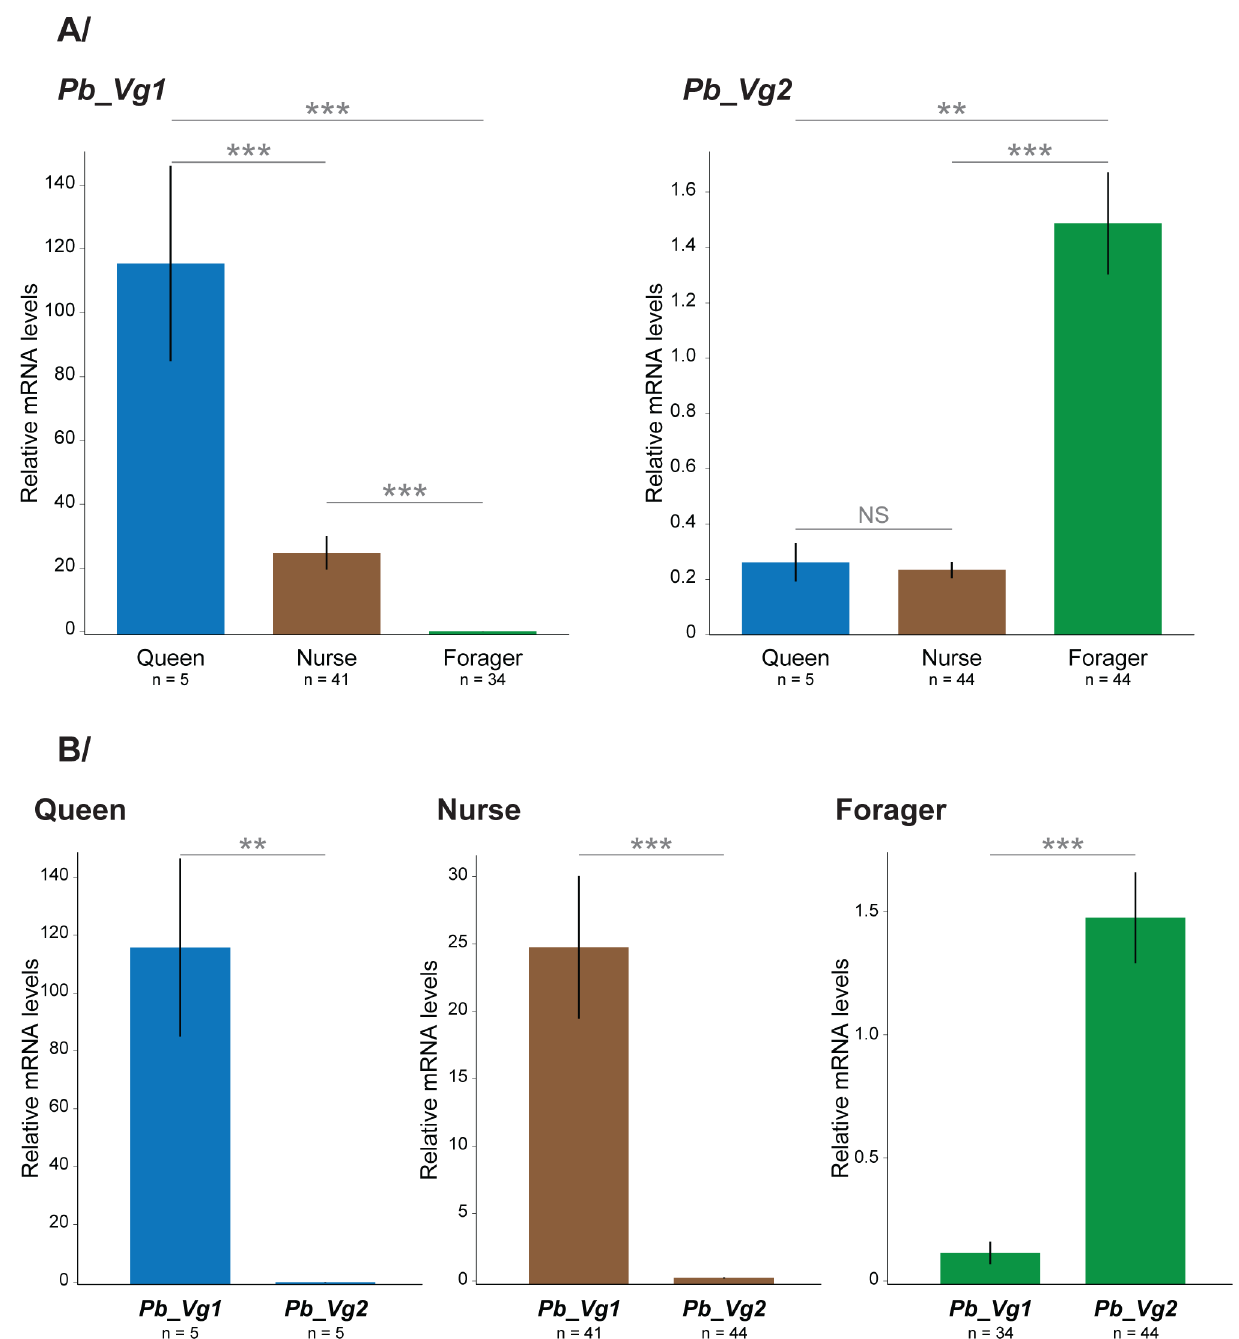
Figure 3. Relative mRNA levels of Pb_Vg1 and Pb_Vg2 in queens, nurses and foragers. Values were pooled from five independent colonies (Figure S1). The y axes indicate the relative gene expression, corresponding to the Pb_Vg1 and Pb_Vg2 mRNA levels relative to the ribosomal protein RP49 (control) gene mRNA level (mean 6 se). The upper panel (A) compares the expression levels of each Vg gene among queens, nurses and foragers. The lower panel (B) compares the expression of both Vg genes separately in queens, nurses and foragers. after the divergence between the poneroid and formicoid clades. have contributed to the evolution of modern ants. Second, the The poneroid clade includes primitive ants of the subfamily initial pair of Vg paralogs did not experience further duplication Ponerinae while the formicoid clade includes the three main or losses in the lineages leading to Pogonomyrmex barbatus and Atta cephalotes but the ancestor of Pb_Vg2 appears to be lost subfamilies of modern ants: Myrmicinae, Dolichoderinae and Formicinae [28,42]. Because the divergence between primitive in Camponotus floridanus . Third, several rounds of duplications and modern ants apparently coincided with the duplication of Vg occurred independently in the lineages leading to Solenopsis invicta , Linepithema humile and Acromyrmex echinatior , giving rise to multiple genes, it is tempting to speculate that this molecular event could